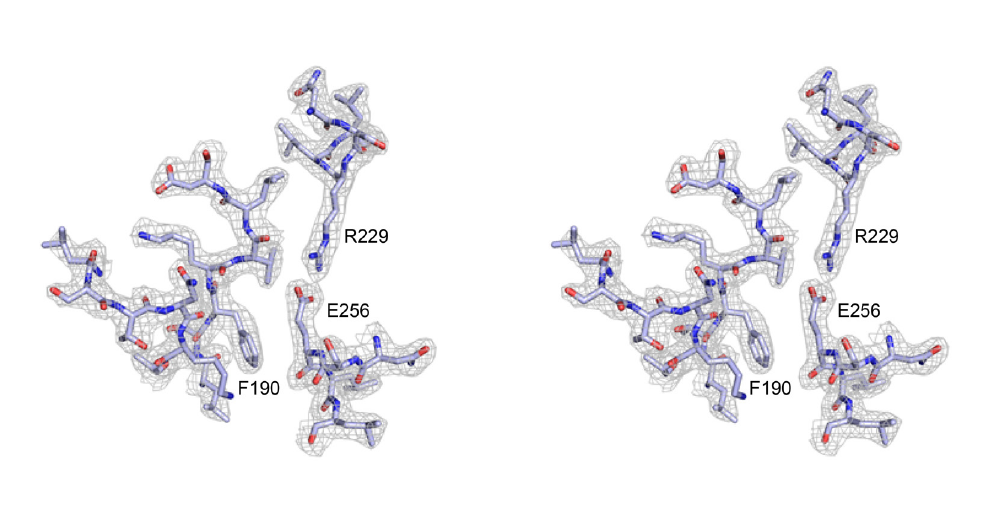
Supplementary Figure 2. Electron density of RSV strain B18537 DS-Cav1 F glycoprotein around the Cav1 residue Phe190 shown in stereo image. The 2F shown in gray mesh format. Amino acid residues are shown in stick